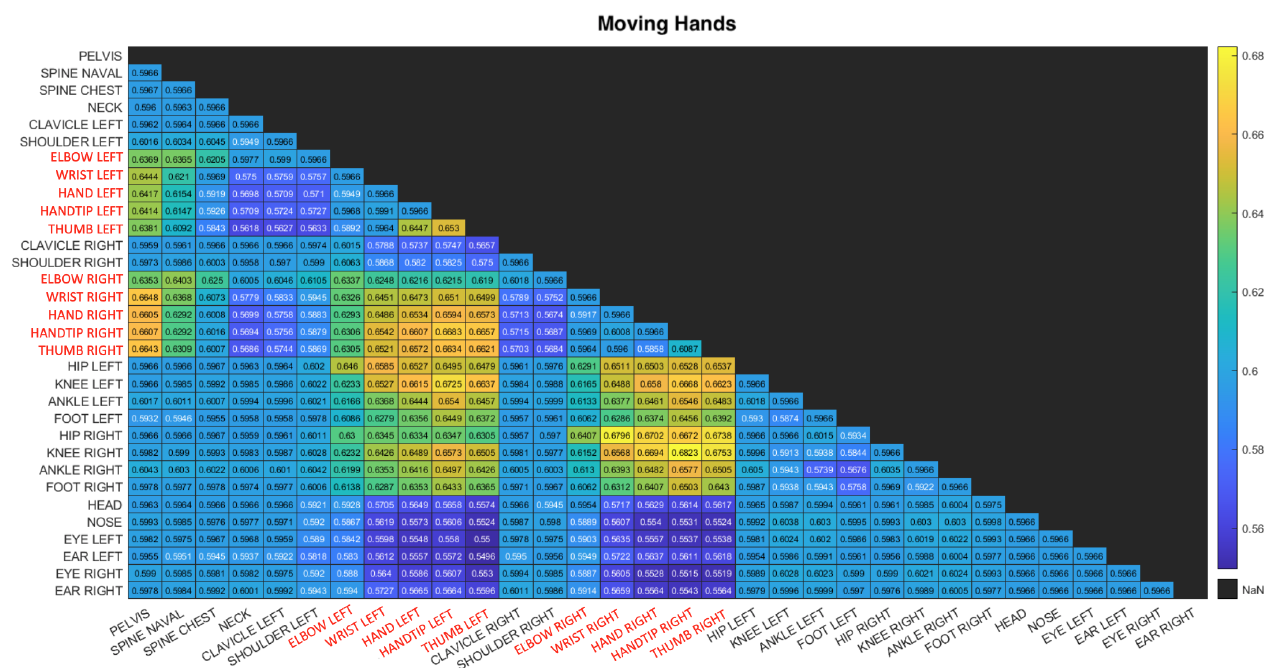
Figure 10. Matrix of Coefficient of Variation values (CV) for a session with hand movement only. It can be seen that the highest CV values are associated with at least one body joint from the hands (colored in red).